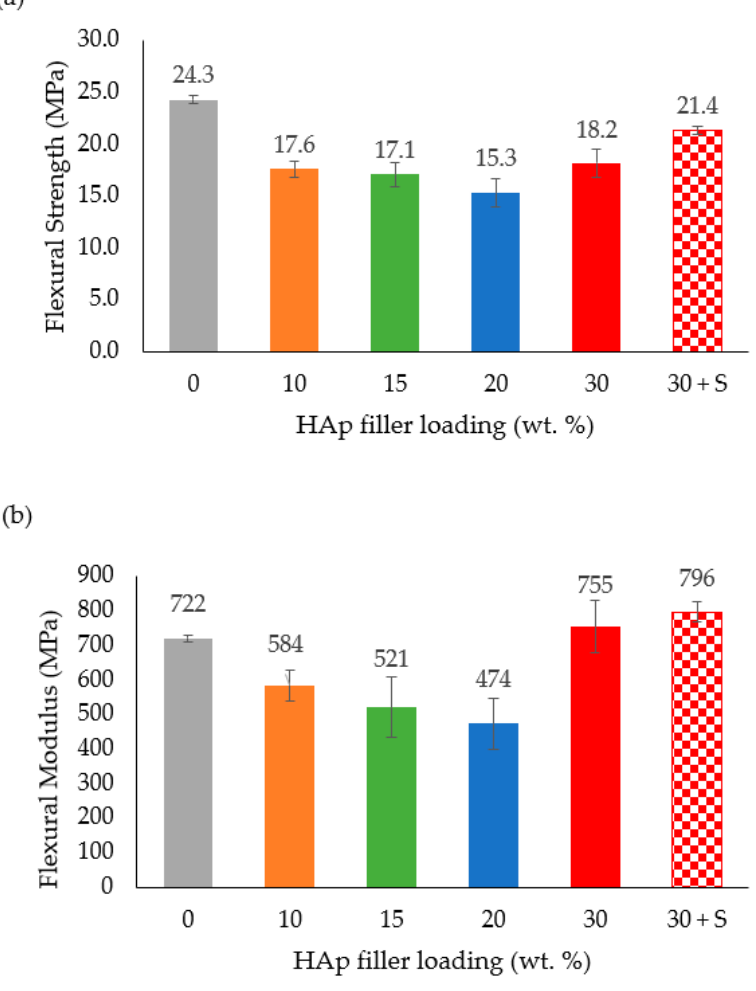
Figure 7. EffectofHApfilleron( a )flexuralstrengthand( b )flexuralmodulusoftheHDPE/HApcomposites. Figure 7. Effect of HAp filler on ( a ) flexural strength and ( b ) flexural modulus of the HDPE/HAp composites. The flexural modulus of the HDPE/HAp composites as a function of HAp filler is shown in Figure 7b. Similar to the flexural strength, the flexural modulus decreased with increasing filler loading up to the 20 wt. % HAp mark. Beyond this mark and as compared with the flexural modulus of the pure HDPE (722 MPa), the HDPE/30HAp and HDPE/30HAp-S composites exhibited higher flexural moduli (and corresponding percentage increases) of 755 MPa (4.6%) and 796 MPa (10.3%). The higher flexural modulus demonstrated by the HDPE/30HAp-S composite relative to the untreated counterpart confirms the capacity of the silane treatment in enhancing the rigidity of the composite. The positive effect of silane treatment on the flexural properties of other polymer-matrix composites has also been widely reported in other researches